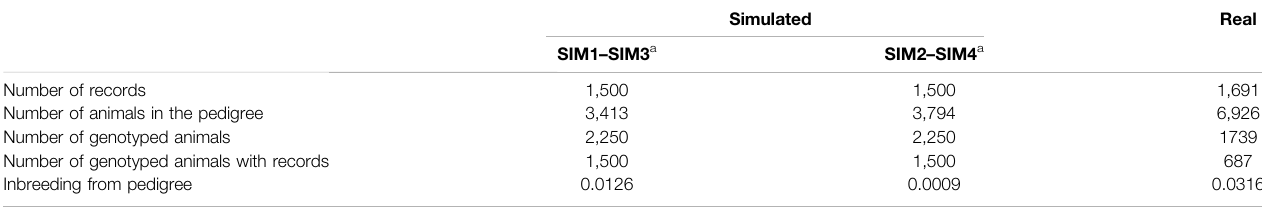
TABLE 2 | Population structure of simulated and real data